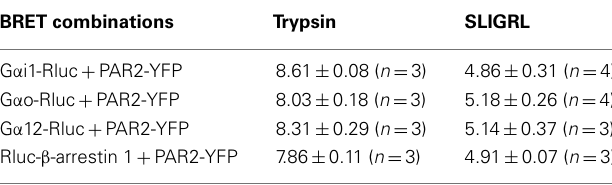
Table 2 | pEC 50 values of trypsin and SLIGRL on BRET signals. BRET combinations Trypsin SLIGRL G α i1-Rluc +